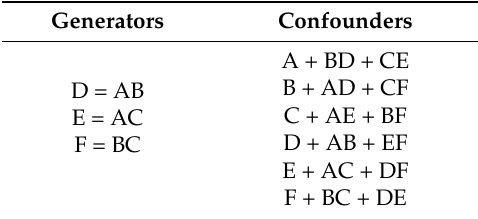
Table 5. Generators and confounders in the array of